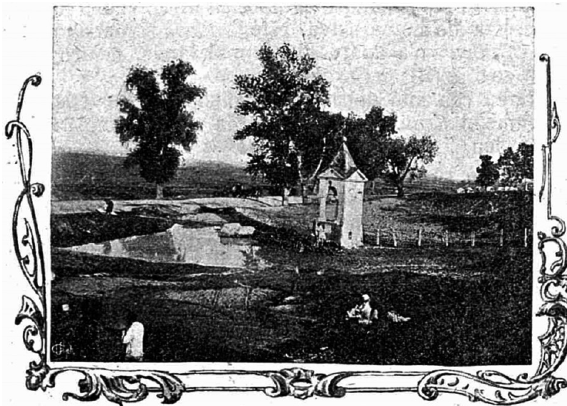
Fig. 9a. The Obedeanu well in year 1927 ( Arhivele Olteniei , 06, no. 31, May–June 1927).